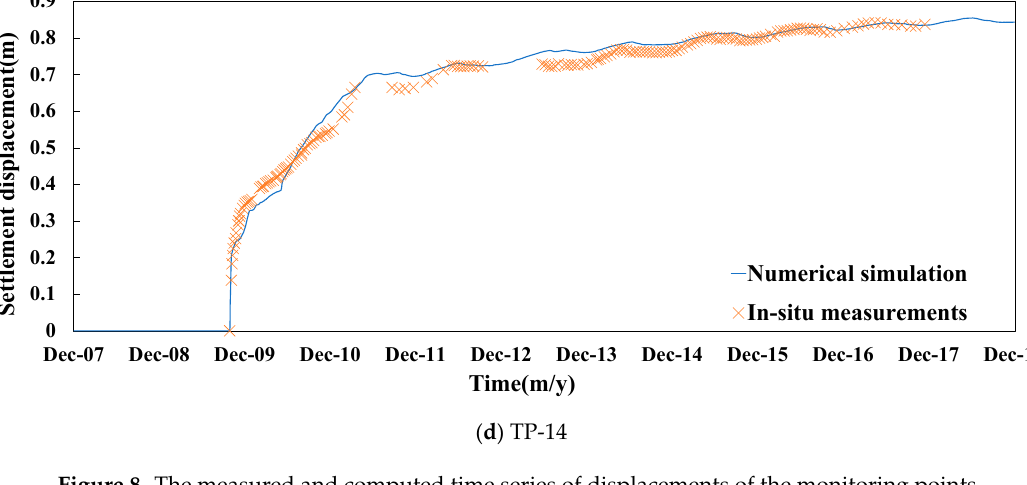
Figure 8. The measured and computed time series of displacements of the monitoring points.